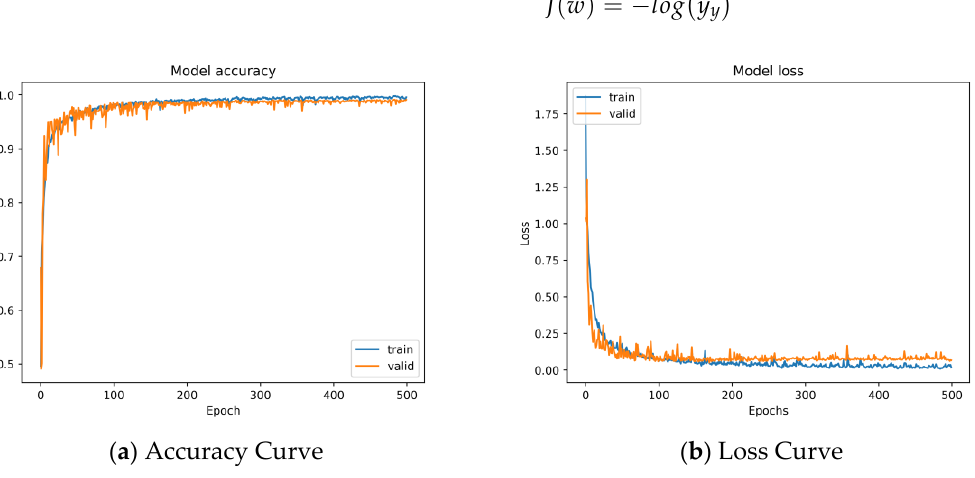
Figure 5 . Accuracy and loss curves of the 1D-CNN model. Figure 5. Accuracy and loss curves of the 1D-CNN